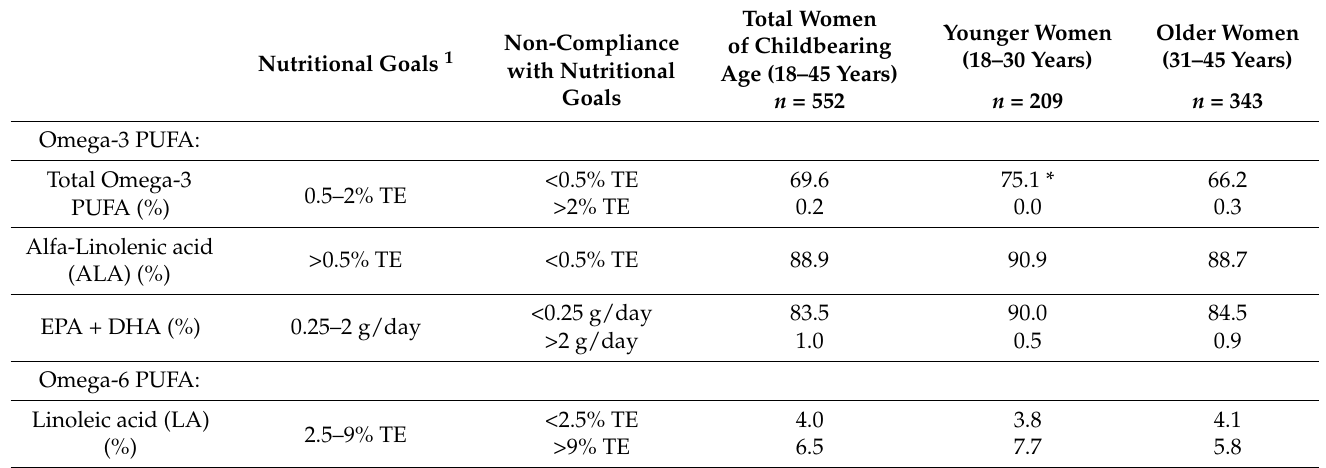
Table 10. Degree of non-compliance with nutritional goals for polyunsaturated fatty acids (PUFA) among women of two childbearing age groups from the ANIBES Study.